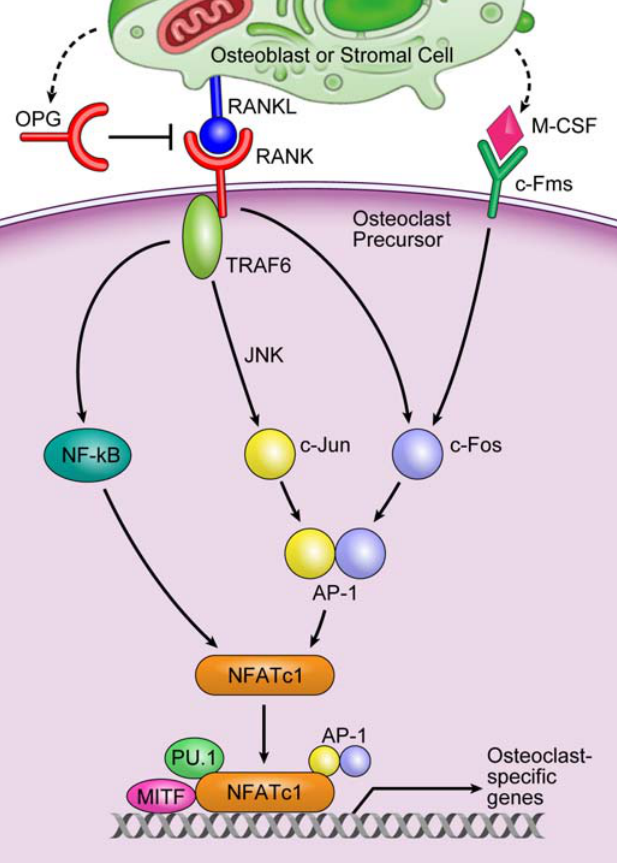
Figure 1. An important signaling cascade of osteoclastogenesis. The binding of M-CSF to its receptor, c-Fms, induces the transcription factor c-Fos, whereas the binding of RANKL to its receptor, RANK, leads to the recruitment of TRAF6, the main adapter molecule of RANK. TRAF6 activates NF- κ B and mitogen-activated kinases including JNK. JNK